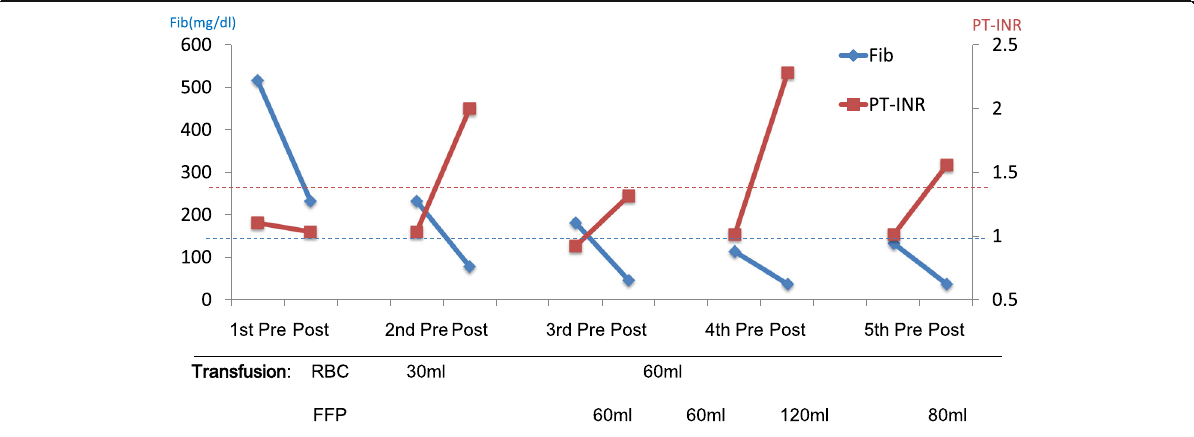
Fig. 3 Coagulation changes for each PE of case no.4. The more PE was performed, the more the coagulation ability becomes abnormal even if the patient was